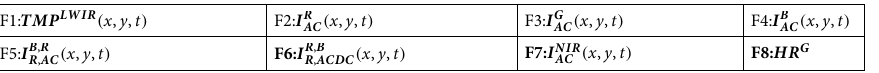
Table 1. A list of the TSTMS features, designed to best represent relevant physiological changes induced by the various examined